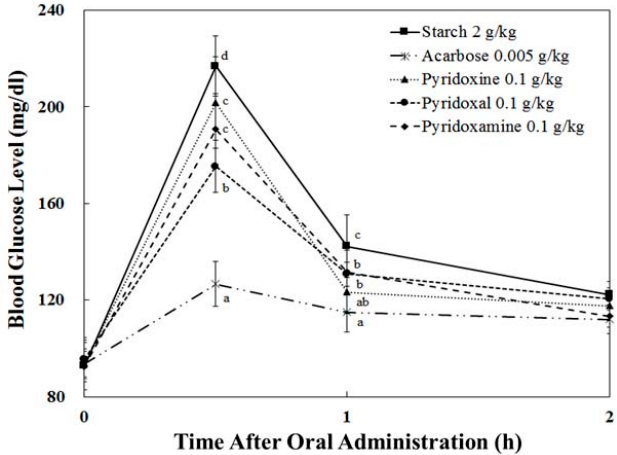
Figure 4. Postprandial blood glucose-lowering effects of pyridoxine, pyridoxal, and pyridoxamine in the starch loading test. After fasting for 24 h, six-week-old, male SD rats were orally administered with a starch solution (2.0 g/kg) with or without samples (pyridoxine, pyridoxal, pyridoxamine, and Acarbose). Each point represents mean ± S.D. ( n = 5). The letters in lowercase ( a–d ) indicate significant differences ( p < 0.05) at 0.5 h and 1.0 h, respectively, via Duncan’s test. Among the three tested compounds, change of blood glucose level in the pyridoxal-treated group with sucrose was increased by 64.88 ± 12.06 mg/dL at 30 min after administration (Figure 5). This is lower than the pyridoxine-treated group (92.86 ± 10.10 mg/dL) and the sucrose group (101.27 ± 20.18 mg/dL) by 27.98 mg/dL and 36/39 mg/dL, respectively. At 30 min after administration, we found that the blood glucose level of the pyridoxal-treated group was 164.74 ± 12.06 mg/dL, which was 27.76 mg/dL less than that of the pyridoxine-treated group (192.50 ± 10.10 mg/dL) and 35.89 mg/dL less than that of the sucrose-treated group (200.63 ± 20.18 mg/dL).